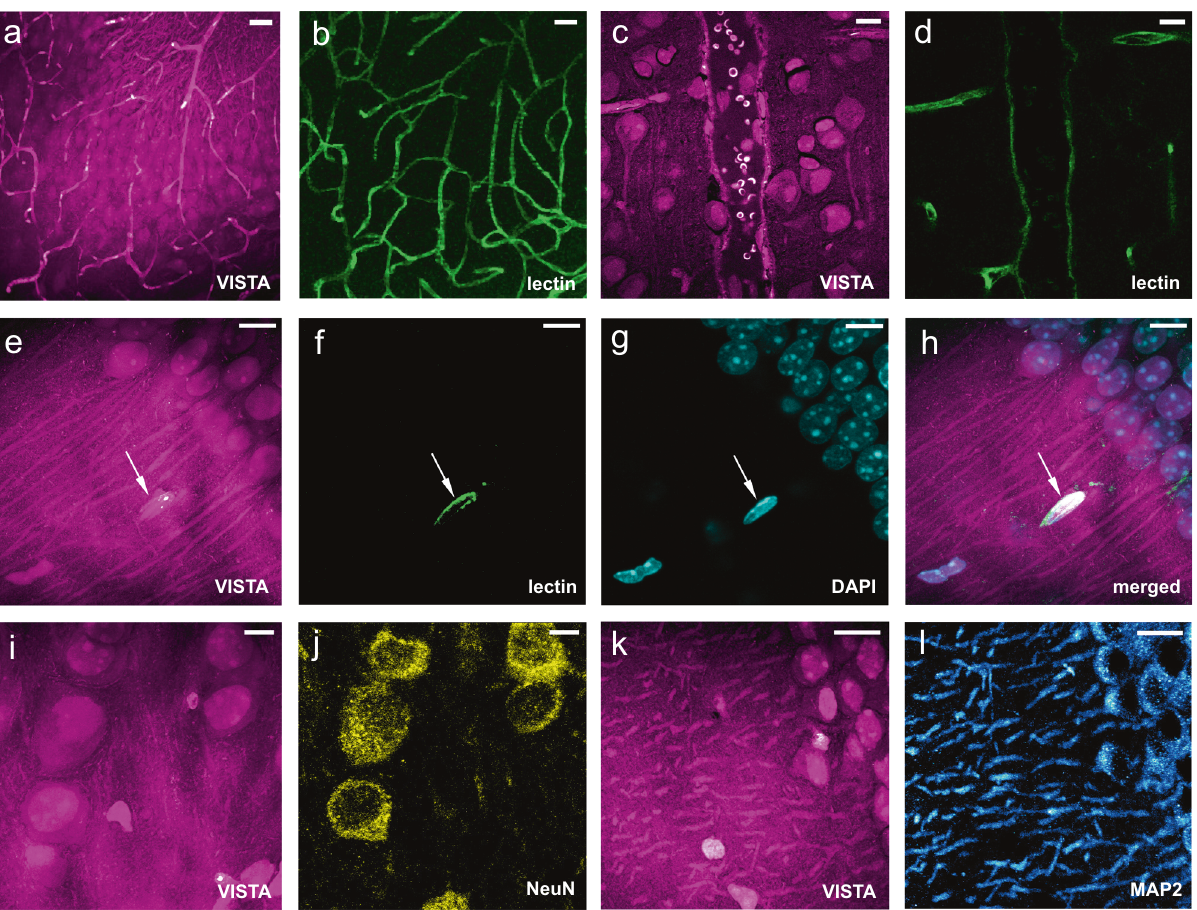
Fig. 3 Validation of VISTA imaging features with fl uorescent markers on mouse brain tissues. a – d Parallel images of VISTA ( a , c ) and fl uorescence from lectin-DyLight594 stained blood-vessel ( b , d ) in vessel-abundant regions. e – g Parallel images of VISTA ( e ) with two-color fl uorescence from lectin- DyLight594 stained vessels ( f ) and DAPI-stained nuclei ( g ). h Three-channel merged image from ( e – g ). i , j Parallel images of VISTA ( i ) and fl uorescence from immuno-stained NeuN, the matured neuron marker ( j ). k , l Parallel images of VISTA ( k ) and fl uorescence from immuno-stained MAP2, the neuronal cell body, and dendrite marker ( l ). All images are shown as maximum intensity projection from a stack of volume images. Scale bars: 40 μ m. The length scale is in terms of distance after sample